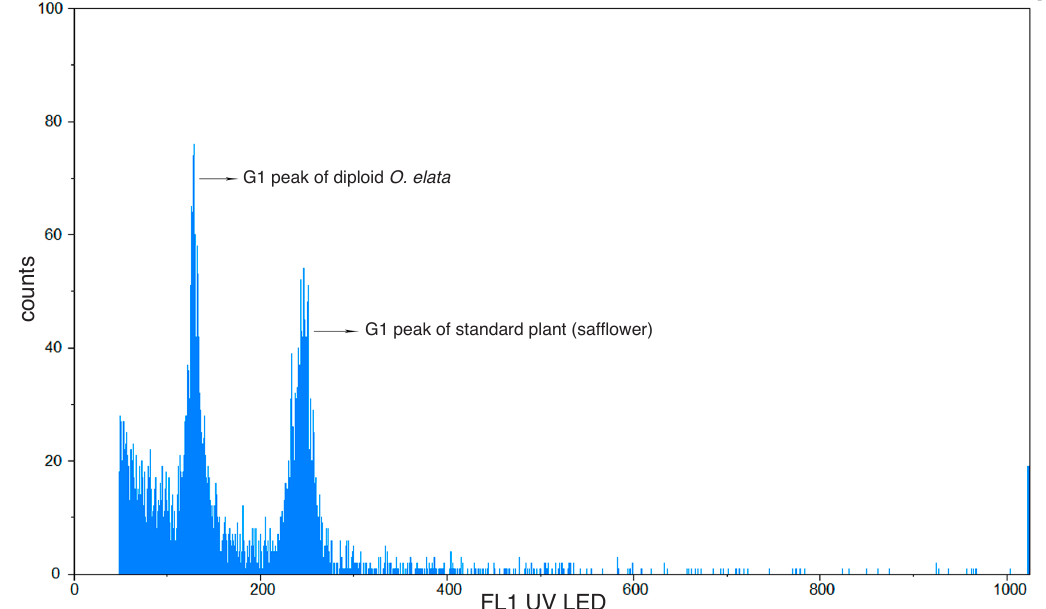
Fig. 3: Positions of G1 peaks belonging to diploid O. elata and standard plants